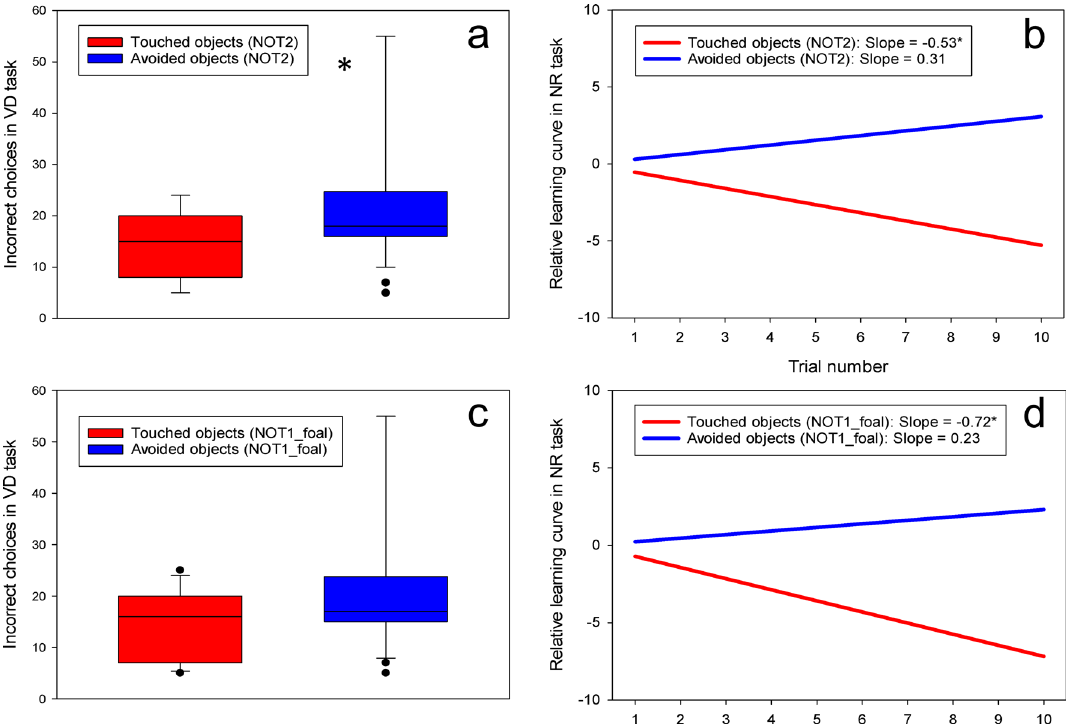
Figure 1. Learning performance of horses that either showed or did not show object-directed exploratory behaviour. ( a ) Horses that touched (red, n = 19) novel objects at 1-year (NOT2) made fewer incorrect container choices in the Visual Discrimination task (VD, p = 0.033), and ( b ) learnt more quickly in the Negative Reinforcement task (NR, p = 0.011). A negative slope indicates learning as the required pressure drops across the 10 trials. ( c , d ) A similar trend was observed already from the foal test at 5 months (NOT1) where foals that touched objects (red, n = 11) learnt more quickly in the NR test (p = 0.012), whereas the result did not reach significance in the VD test (p = 0.12). ( a , c ) Box shows median, interquartile range, lines show min and max and dots represent outliers. ( b , d ) Relative slopes; *indicates that the slope differs significantly from zero. Supplementary Figs. S1 and S2 online show plots of the raw